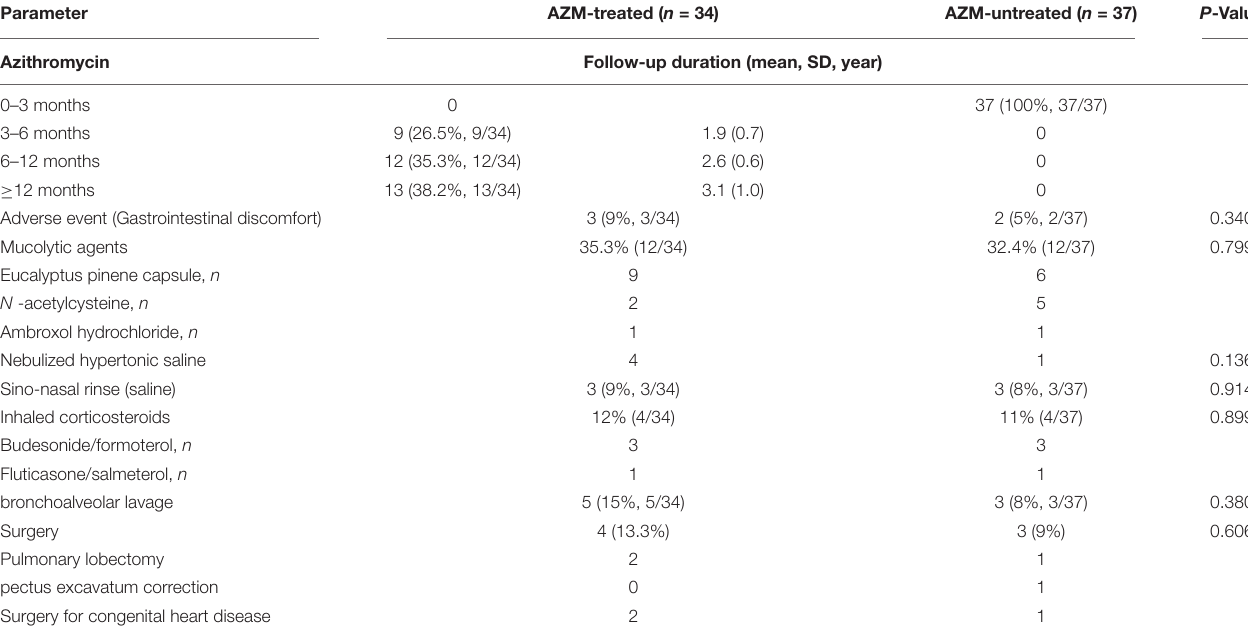
TABLE 2 | Management of 71 children with PCD.